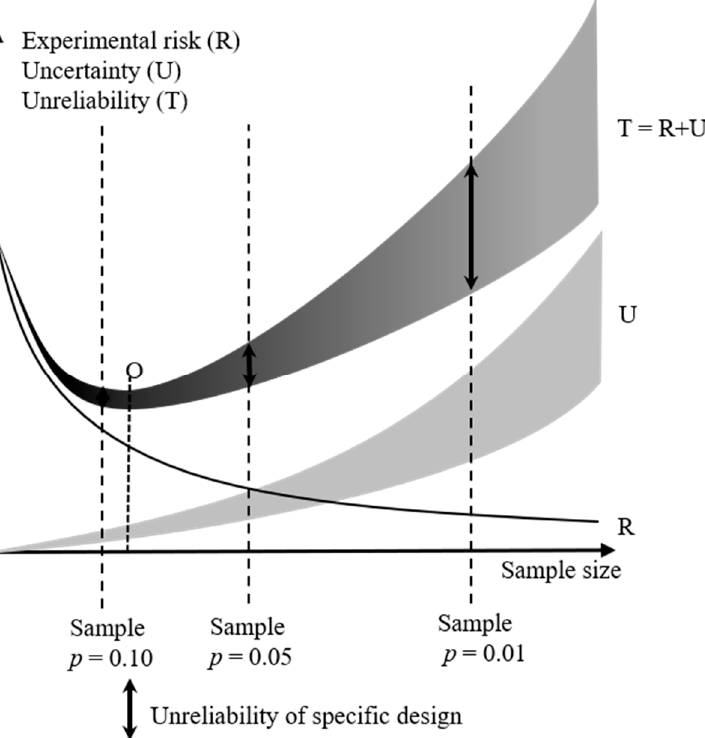
Figure 2. Graphical representation of the interaction of risk, uncertainty and unreliability as a function of experimental sample size.